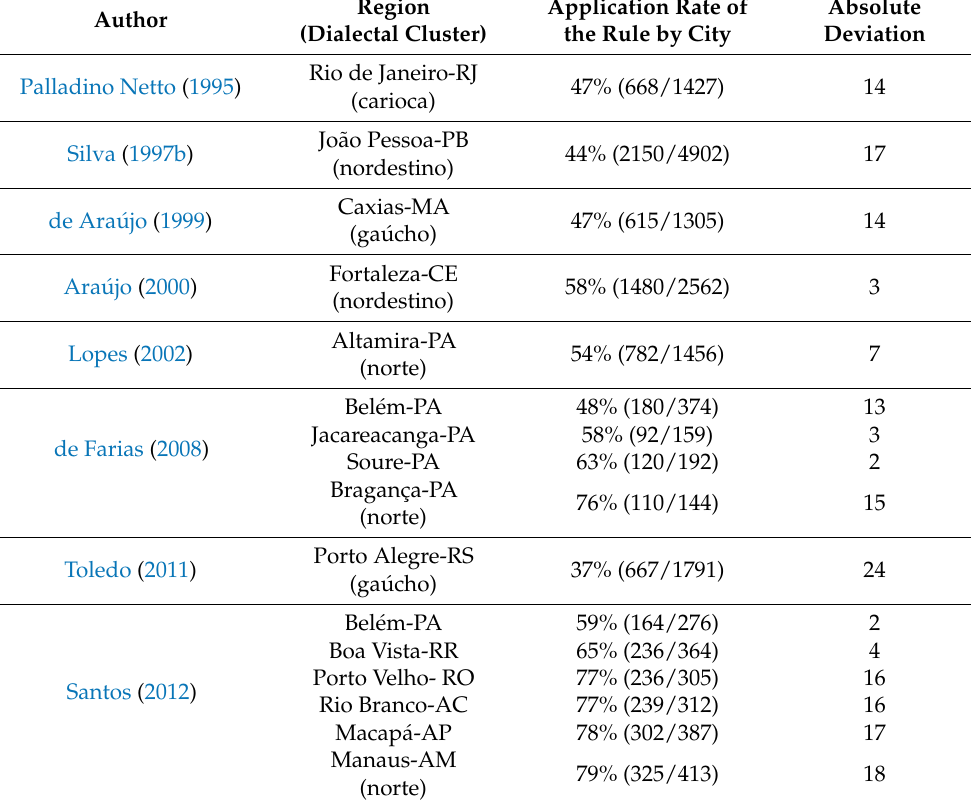
Table 2. Application rate of the monophthong rule by